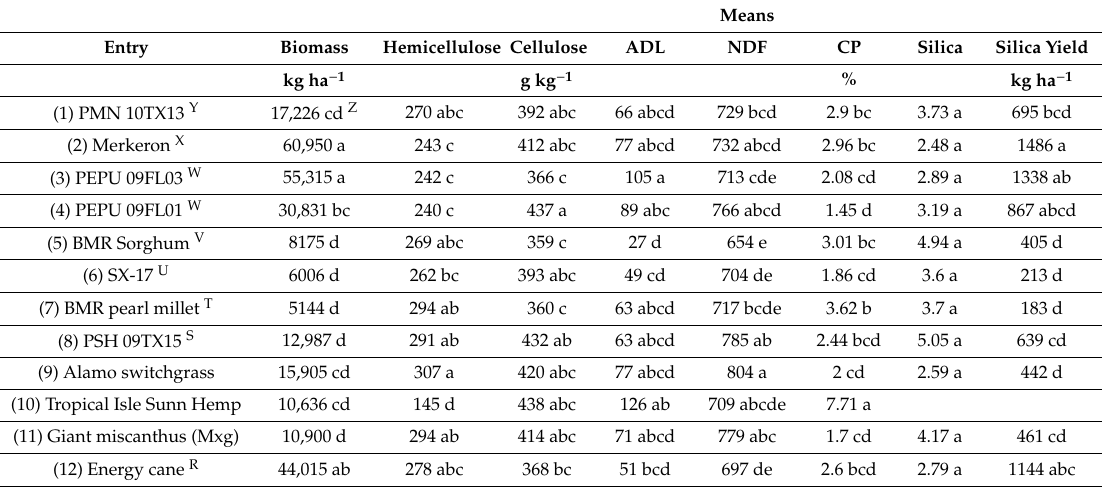
10,900 d Z Means within a column under each main factor followed by the same letter (a,b,c,d) are not significantly di ff erent according to All Pairs Grouping, Tukey HSD. Y Pearl millet napiergrass hybrid PMN 10TX13. X Napiergrass